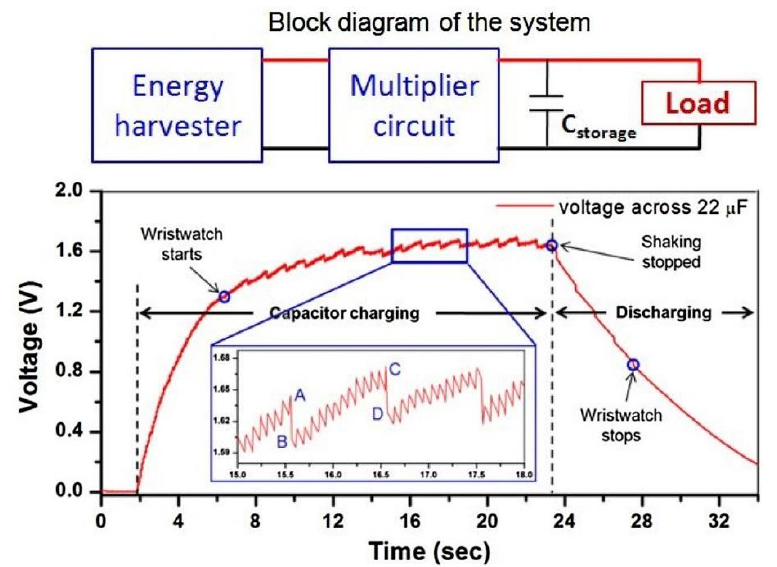
Figure 9. The basic circuit layout for the energy harvesting system described in [8], as well as the system’s capacitor characteristics during operation.